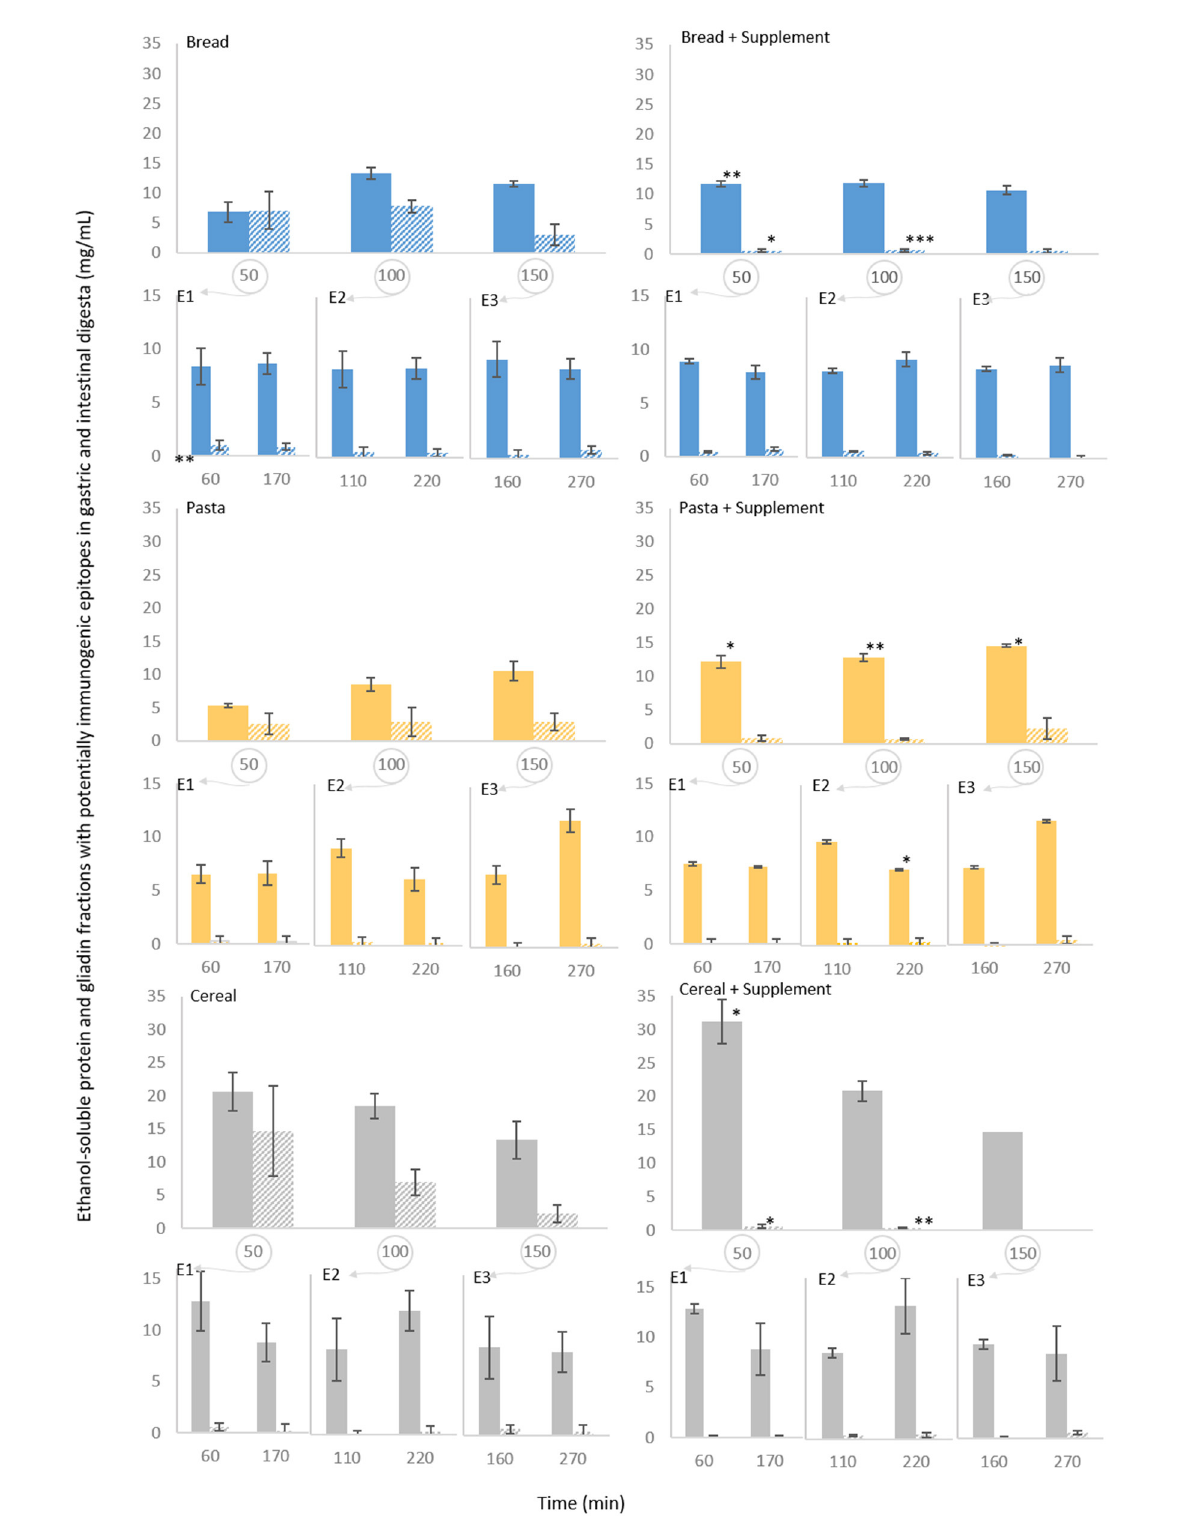
FIGURE6 Persistence of specific epitopes during semi-dynamic in vitro digestions of bread, pasta and breakfast cereal. The results correspond to gastric digesta emptied at 50 (E1), 100 (E2) and 150 (E3) min and the corresponding intestinal digestions. The ethanol-soluble protein fraction (60%